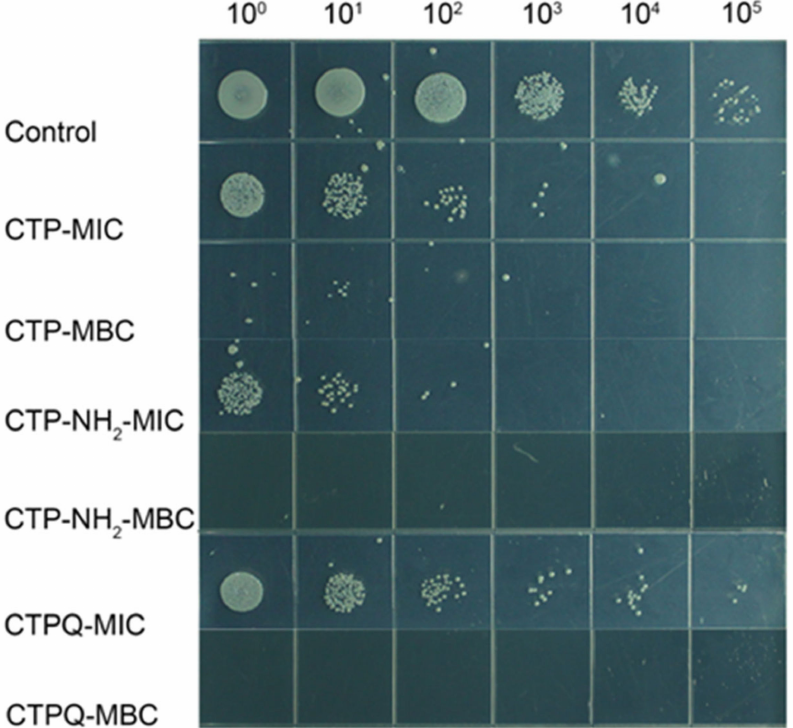
Figure 4. Spot plates of S. aureus ATCC 43300 treated with CTPs (CTP, CTP-NH2, and CTPQ) treatment at the MIC (32 µ g/mL) and the MBC (64 µ g/mL) for 6 h. 10 0 –10 5 : dilution ratio of bacteria